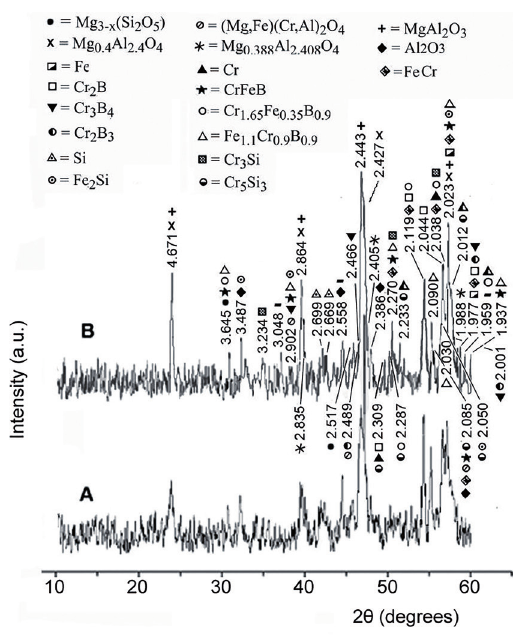
Figure 1: XRD diffraction patterns of the aluminothermic reduction products of the chromium ore concentrate from Cayo Guam deposit and B O . A - chromium/boron ratio = 107/1, B - chromium/boron 2 3 ratio = 50/1.